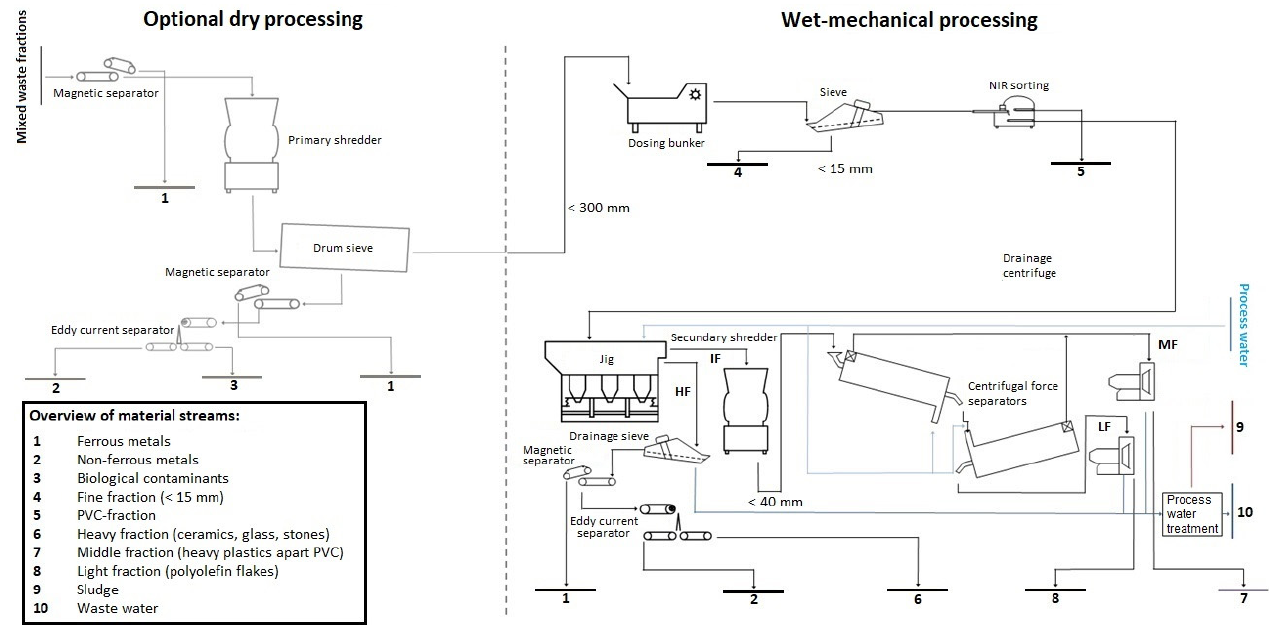
Figure 6. Flow chart of the designed industrial pilot plant [22] (Reproduced with permission from Schwabl D.; Proceedings of the fifteenth Recy and DepoTech- Conference; published by Chair of Waste Processing Technology and Waste Management (Montanuniversitaet Leoben; 2020).